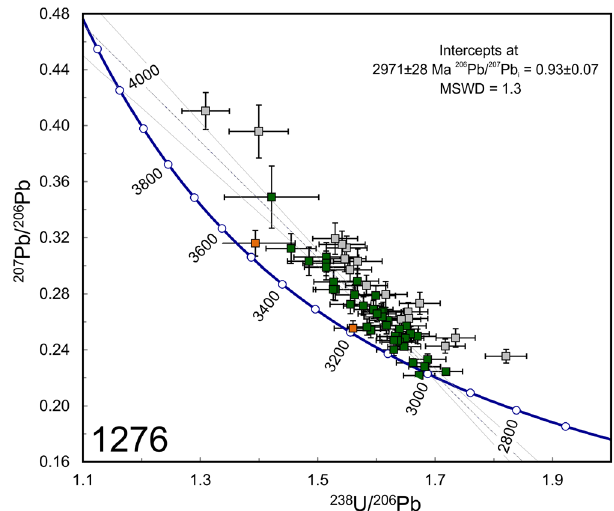
Fig. 7 Tera-Wasserburg Concordia diagram of titanite from sample 1276. Green squares denote main group, gray squares denote potential minor radiogenic-Pb loss, and orange squares denote potential old outliers/ analytical mixtures with epoxy. Error bars are shown at the two- σ level. Uncertainty around the regression line is shown at the 95% con fi dence